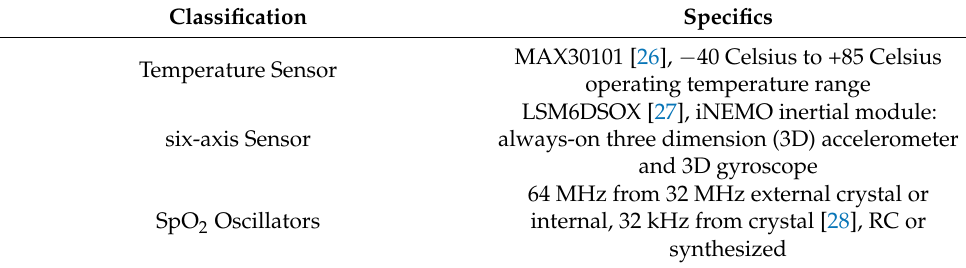
Table 2. Specifications of temperature, six-axis, and SpO 2